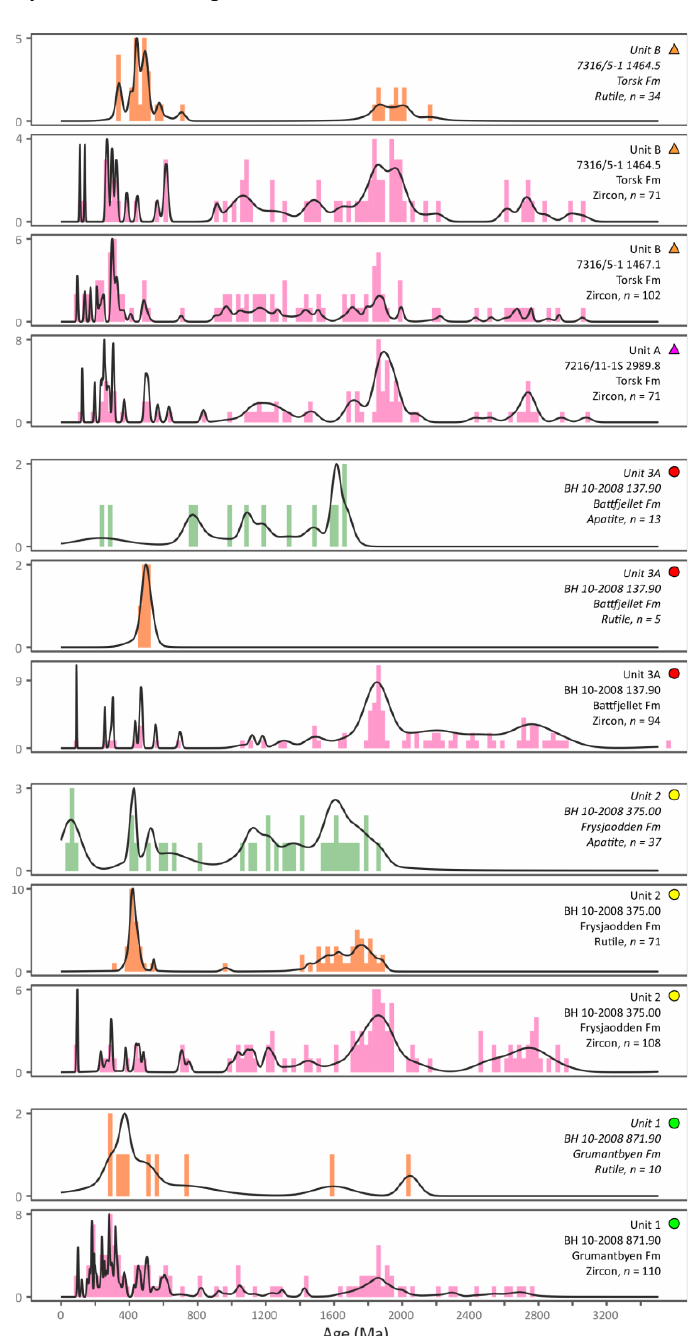
Figure 8. Probability density plots for detrital U-Pb ages determined for zircon (pink), rutile (orange) and apatite (green). This comparison serves to illustrate how patterns obtained from grains that crystallise under different conditions, and vary with respect to their isotopic closure and suscepti- bility sedimentary reworking. Generally, zircons record crystallisation from a silicic melts and are readily recycled, rutiles record cooling after metamorphism within pelitic and mafic rocks and are readily recycled, apatites record cooling after crystallisation within melts or during metamorphism in a variety of rock compositions and less likely to be recycled due to their susceptibility to acidic weathering [26]. Data are separated into the different units, symbolised by the coloured circles and triangles as defined on Figure 2. Italicised sample information indicate samples that yielded a low number of reliable analyses and should be interpreted with caution.